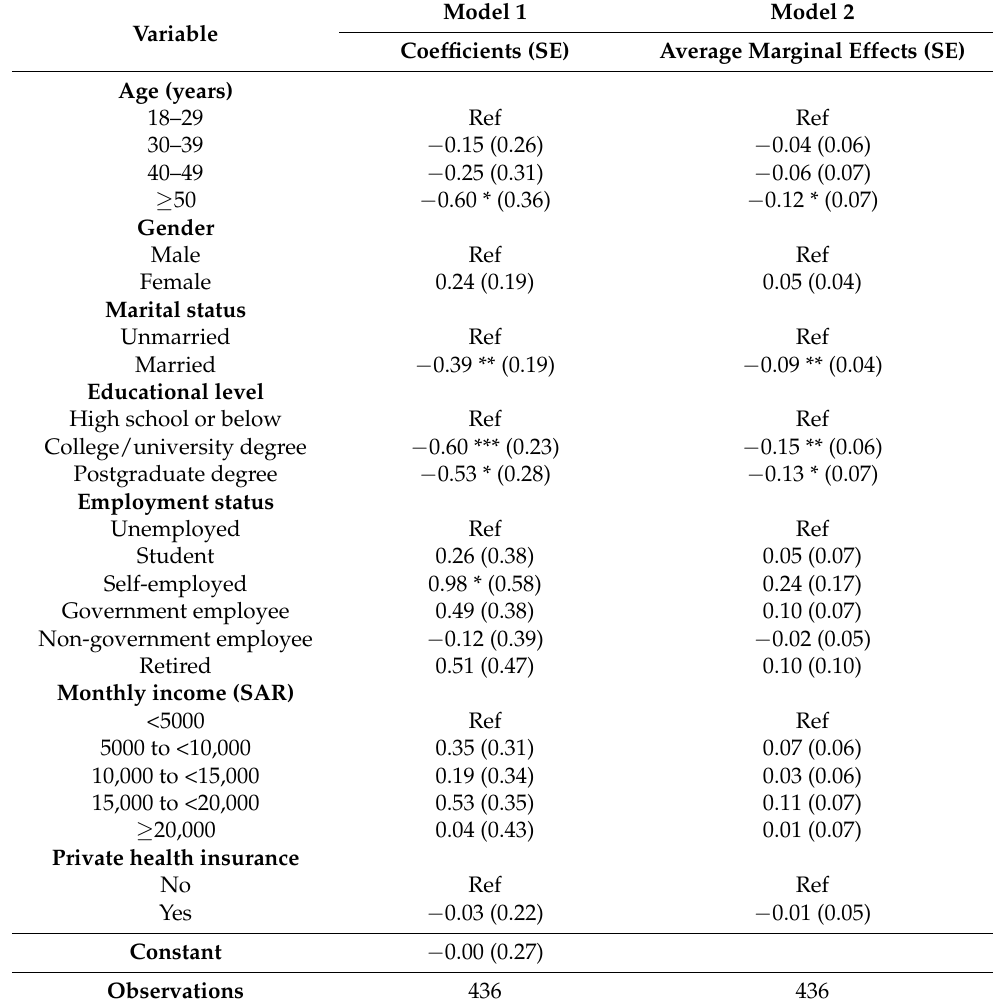
Table 5. Socioeconomic determinants of the maximum amount respondents were willing to pay for immediate public dental